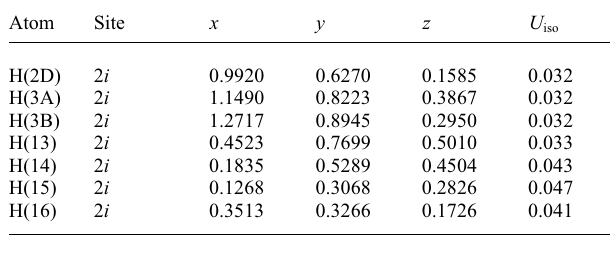
Table 2. Atomic coordinates and displacement parameters (in Å 2 )